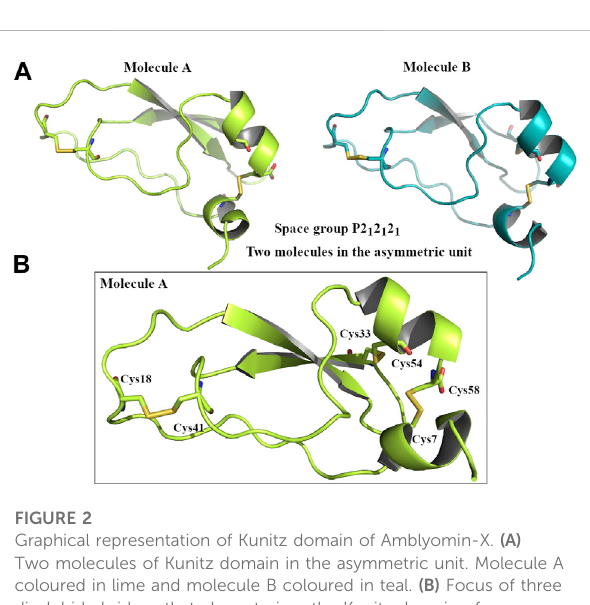
FIGURE 2 Graphical representation of Kunitz domain of Amblyomin-X. (A) Two molecules of Kunitz domain in the asymmetric unit. Molecule A coloured in lime and molecule B coloured in teal. (B) Focus of three disulphide bridges that characterizes the Kunitz domain of